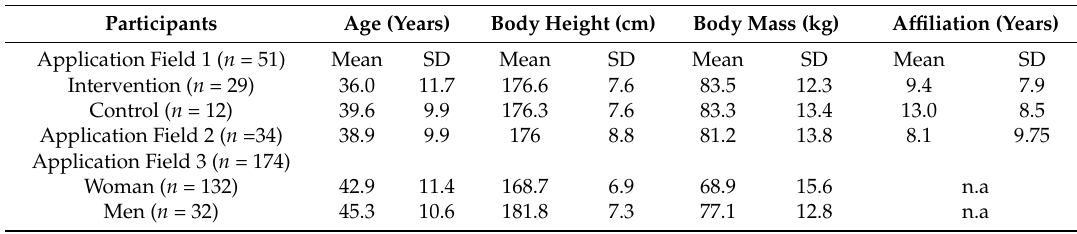
Table 1. Overview of participants all application